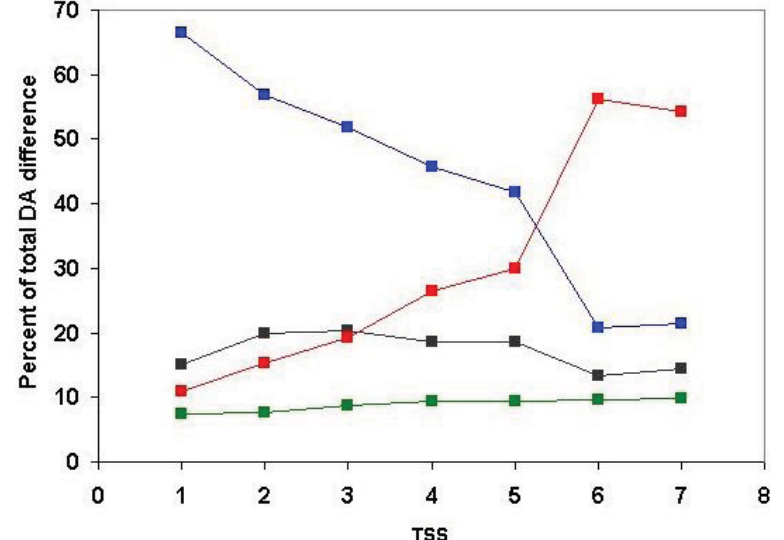
Figure 9. Analysis of the relative frequency of homologous pairs of human Swiss-Prot sequences that differ in the number of domains by 1, 2, 3, ... N domains in clusters defined by strong component analysis of sequence similarity networks of human Swiss-Prot sequences. Note that, in the case of close paralogs (TSS = 1, TSS = 2), the majority of pairs differ in a single domain (blue rectangle) and a small proportion of homologs differs in 2 (black rectangle), 3 (green rectangle) or (cid:3) 4 domains (red rectangle). Inclusion of more distant paralogs had little influence on the proportion of pairs that differ in 2 or 3 domains, however, a sharp increase in the proportion of DA changes involving (cid:3) 4 domains is observed when more than 5 top-scoring matches are included in the analysis. The numbers on the abscissa indicate the number of top-scoring matches included in the analyses used to define paralogous